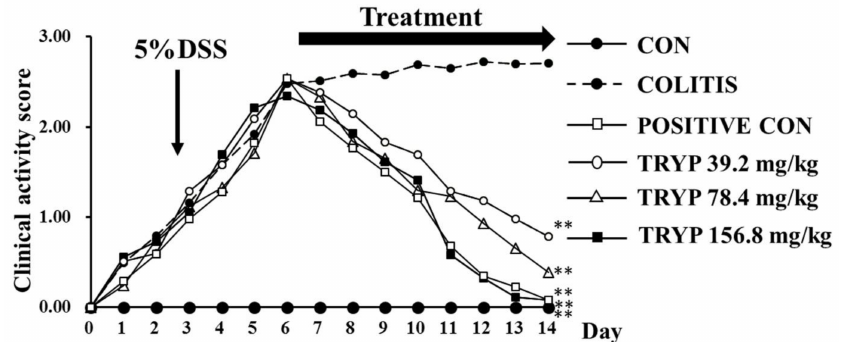
Figure 2. CAS of groups. After colitis induction, the animals were treated for 8 days with distilled water, DSS, sulfasalazine (“positive con”) and three concentrations of TRYP. Mice in colitis, positive control and TRYP groups were also given DSS during treatment. The untreated showed no significant improvement after 14 days while treatment with sulfasalazine and three concentrations of TRYP has significantly improved the CAS of colitis mice. n = 6, ** p < 0.01 compared with